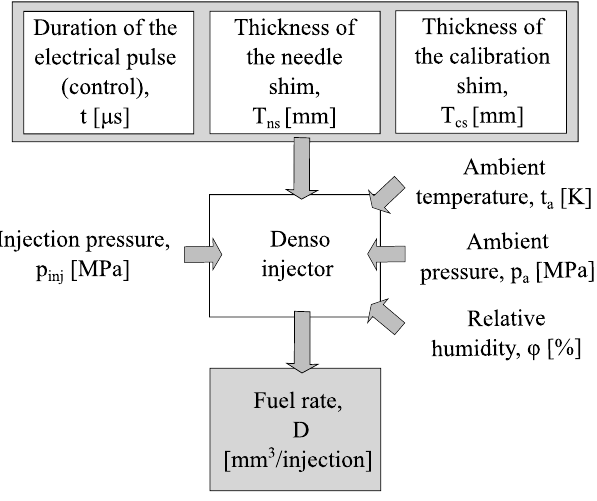
Fig. 5. Qualities defining the object under research